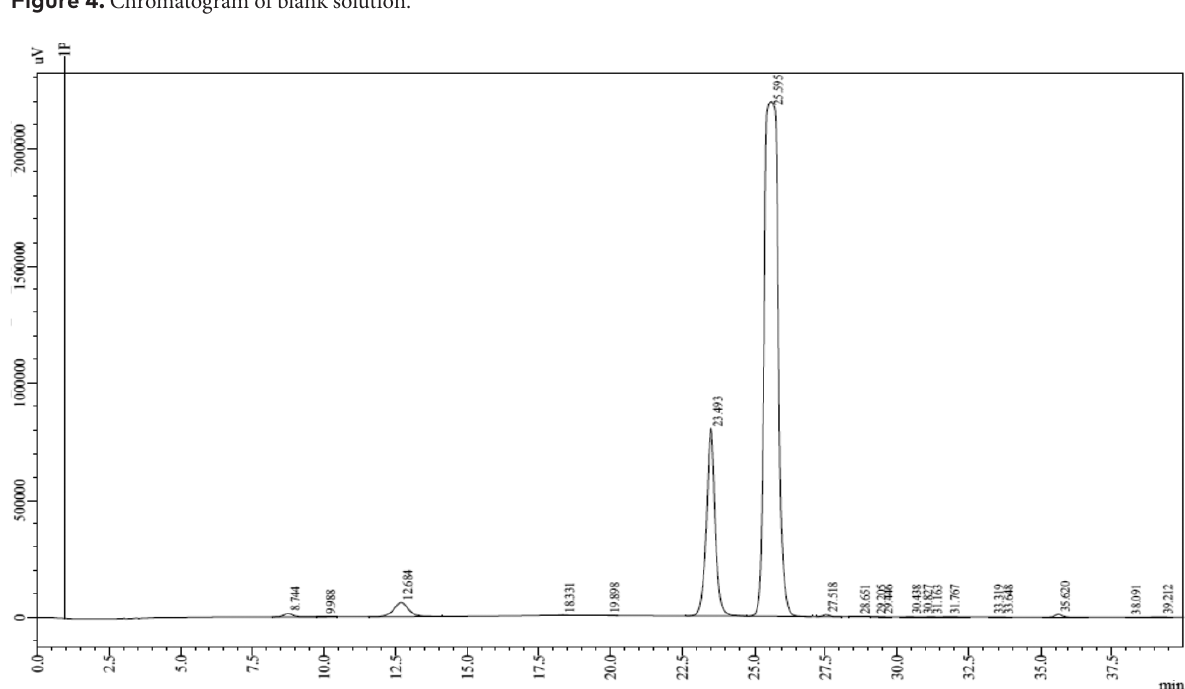
Figure 5. Chromatogram of the test solution (a) after exposure to UV resolution between quinabut peak and impurity A (Res 1).